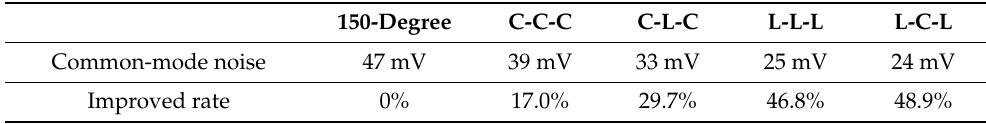
Table 3. Values of simulated common-mode